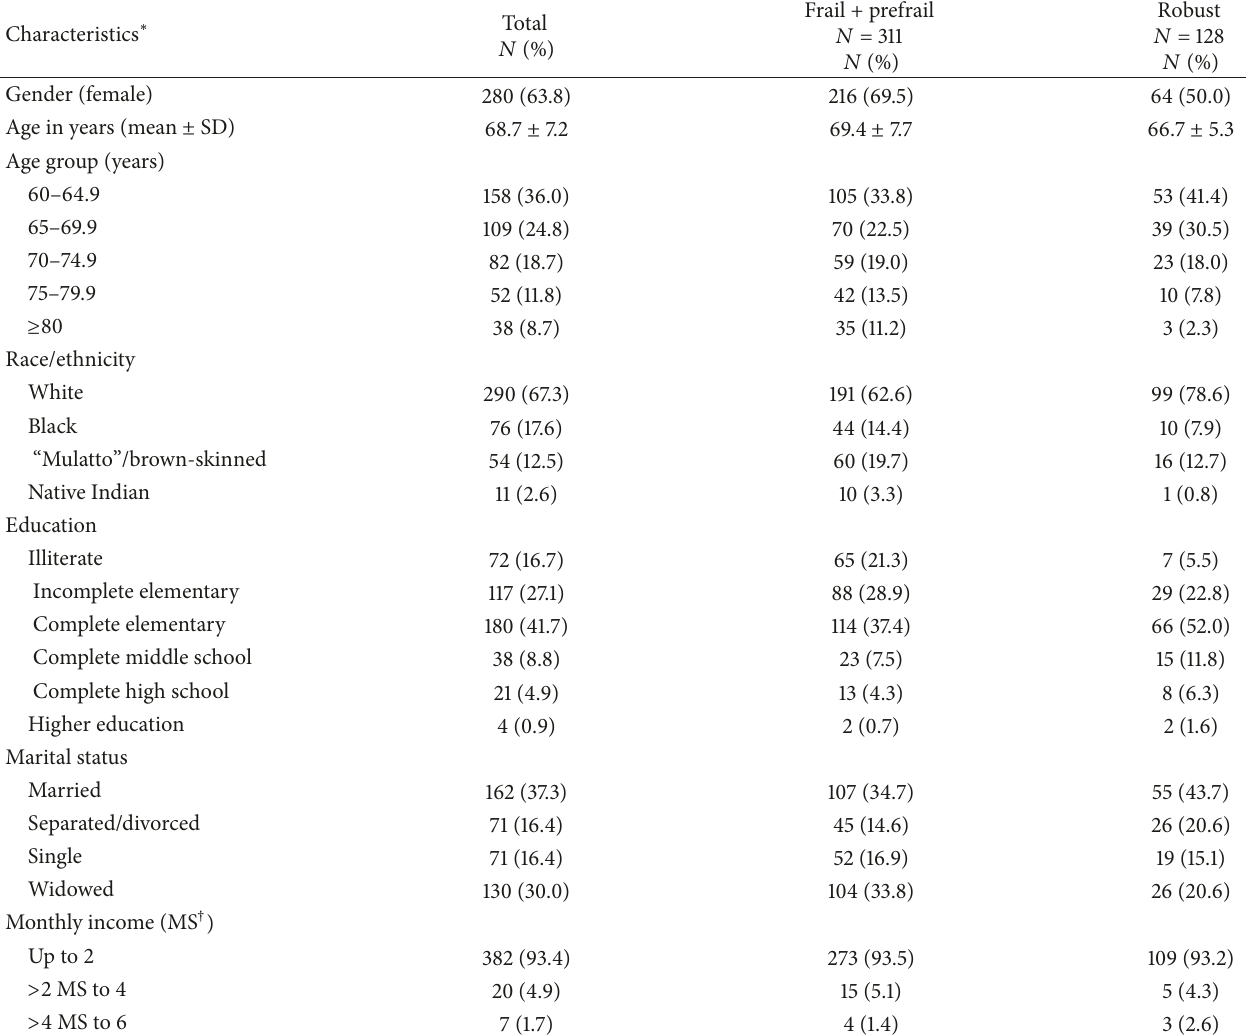
Table 1: Sociodemographic characteristics of older adults who were assisted at primary health care